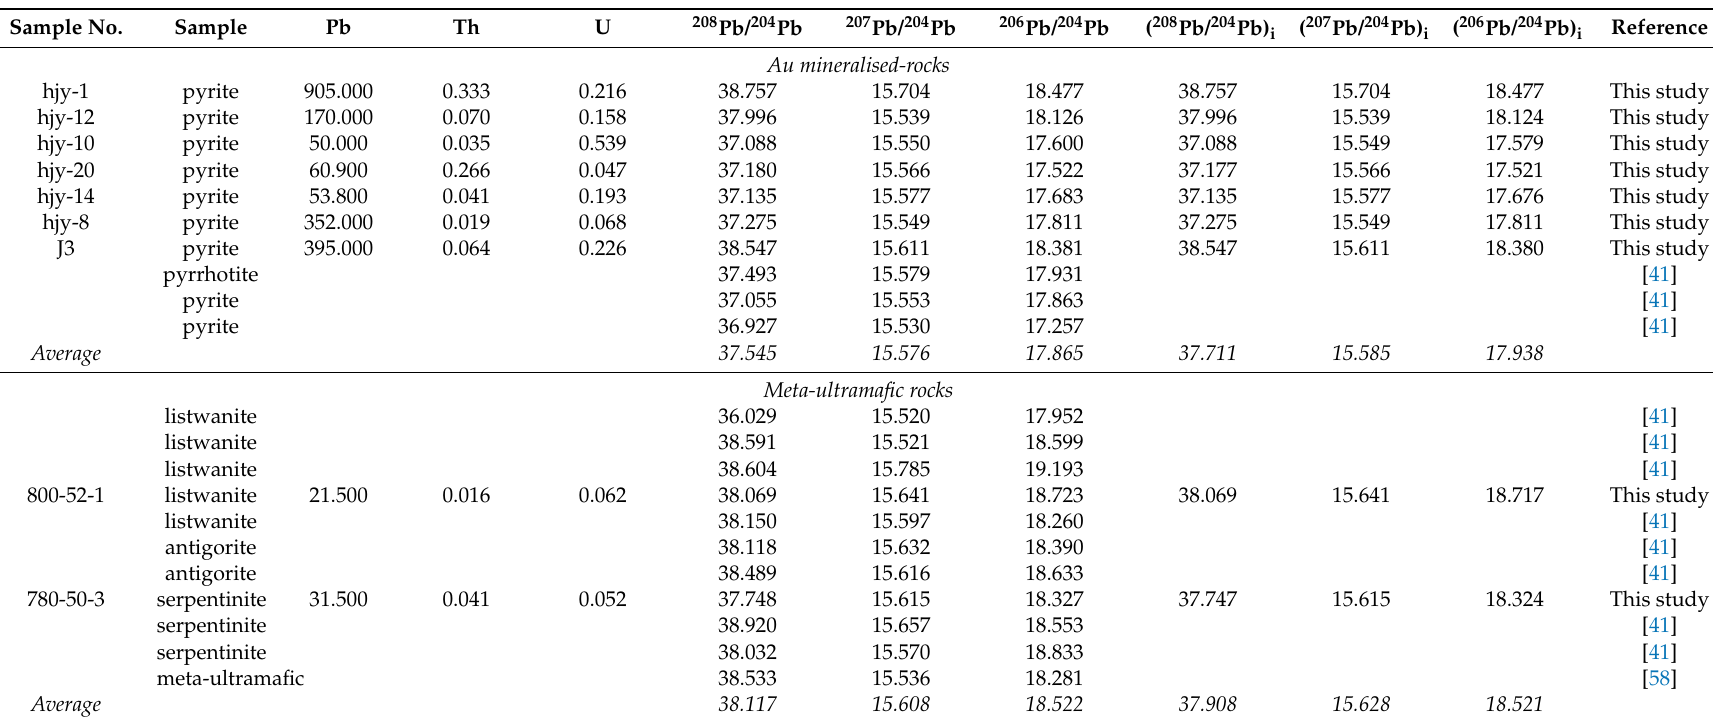
Table 4. Lead isotope composition of ore sulfide and wallrocks at the Jianchaling deposit and in the Bikou Group. Sample